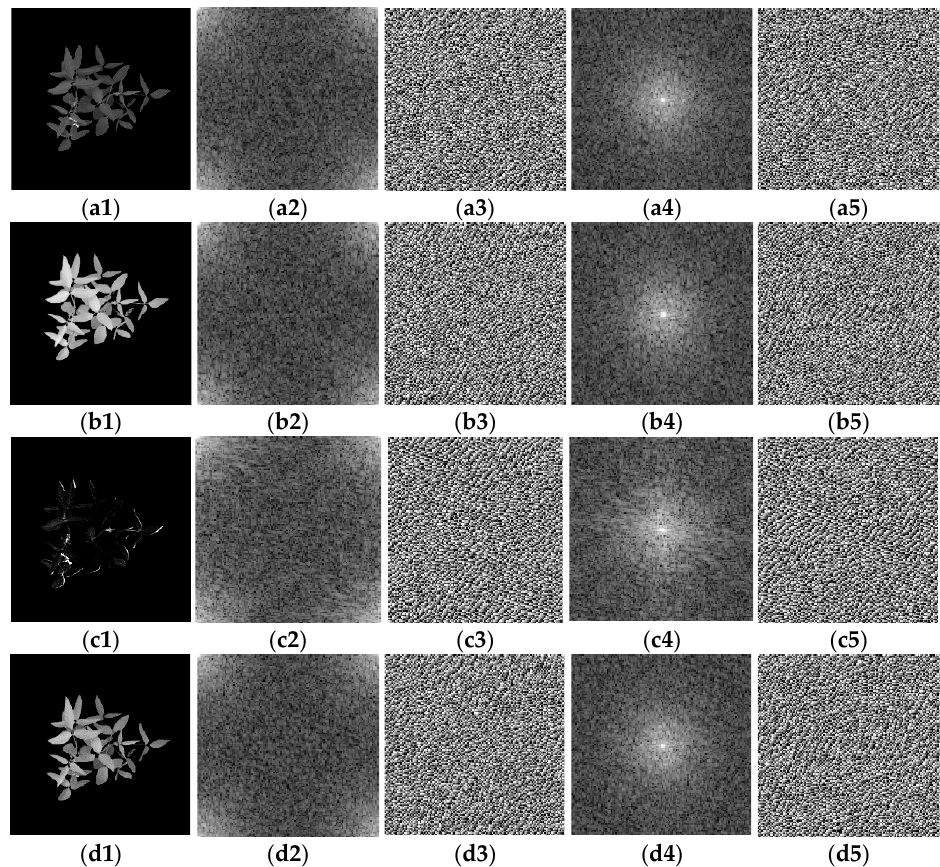
Figure 14. Amplitude spectrum and phase spectrum of the soybean canopy’s multispectral image: ( a1 ) GRE canopy, ( a2 ) GRE amplitude spectrum, ( a3 ) GRE phase spectrum, ( a4 ) GRE amplitude spectrum after the frequency shift, ( a5 ) GRE phase spectrum after the frequency shift, ( b1 ) NIR canopy, ( b2 ) NIR amplitude spectrum, ( b3 ) NIR phase spectrum, ( b4 ) NIR amplitude spectrum after the frequency shift, ( b5 ) NIR phase spectrum after the frequency shift, ( c1 ) RED canopy, ( c2 ) RED amplitude spectrum, ( c3 ) RED phase spectrum, ( c4 ) RED amplitude spectrum after the frequency shift, ( c5 ) RED phase spectrum after the frequency shift, ( d1 ) REG canopy, ( d2 ) REG amplitude spectrum, ( d3 ) REG phase spectrum, ( d4 ) REG amplitude spectrum after the frequency shift and ( d5 ) REG phase spectrum the after frequency shift. Figure 14a2,b2,c2,d2,a4,b4,c4,d4 amplitude spectra showed that the low-frequency